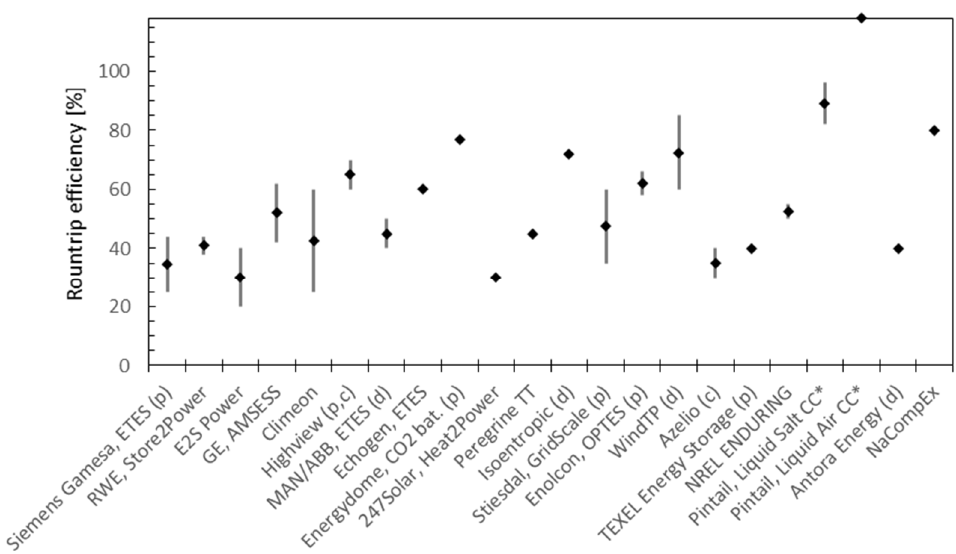
Figure 6. Overview of round trip efficiency in the commercially CB systems (mostly declared as experimental values are limited). In notation (d) stands for demo, (p) pilot, (c) commercial units (built or under construction), * for systems with additional fuel firing.